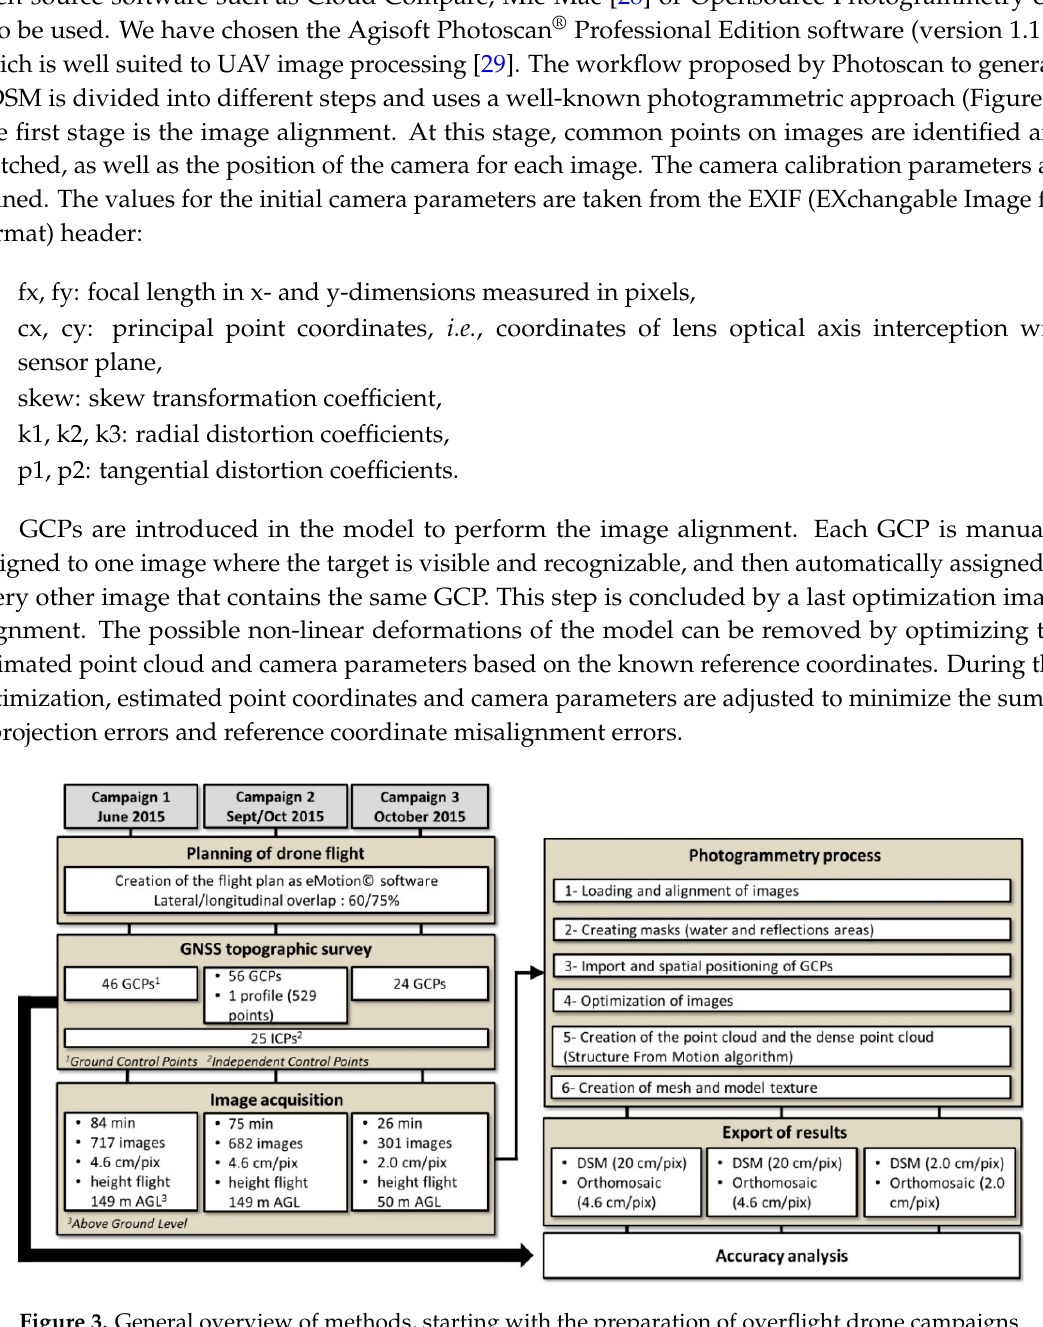
Figure 3. General overview of methods, starting with the preparation of overflight drone campaigns until the determination of DSM and orthomosaic accuracy by GNSS data (profile and ICPs). Then, a dense point cloud is computed, georeferenced in a real-world coordinate system, and a The results (DSM and orthomosaic) are exported according to a selected projection system and a spatial